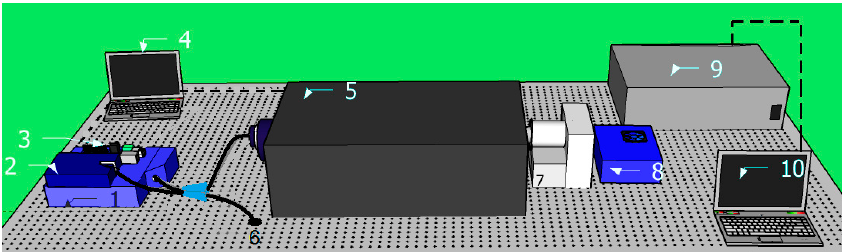
Figure 6. Piccolo Doppio characterization using as the light source a narrow band spectral calibration source, with: (1) spectrometer QEPro; (2) spectrometer USB2000+ both from Ocean Optics; (3) Raspberry Pi system; (4) PC for spectrometers remote control, (5) double monochromator OL750D from Gooch &